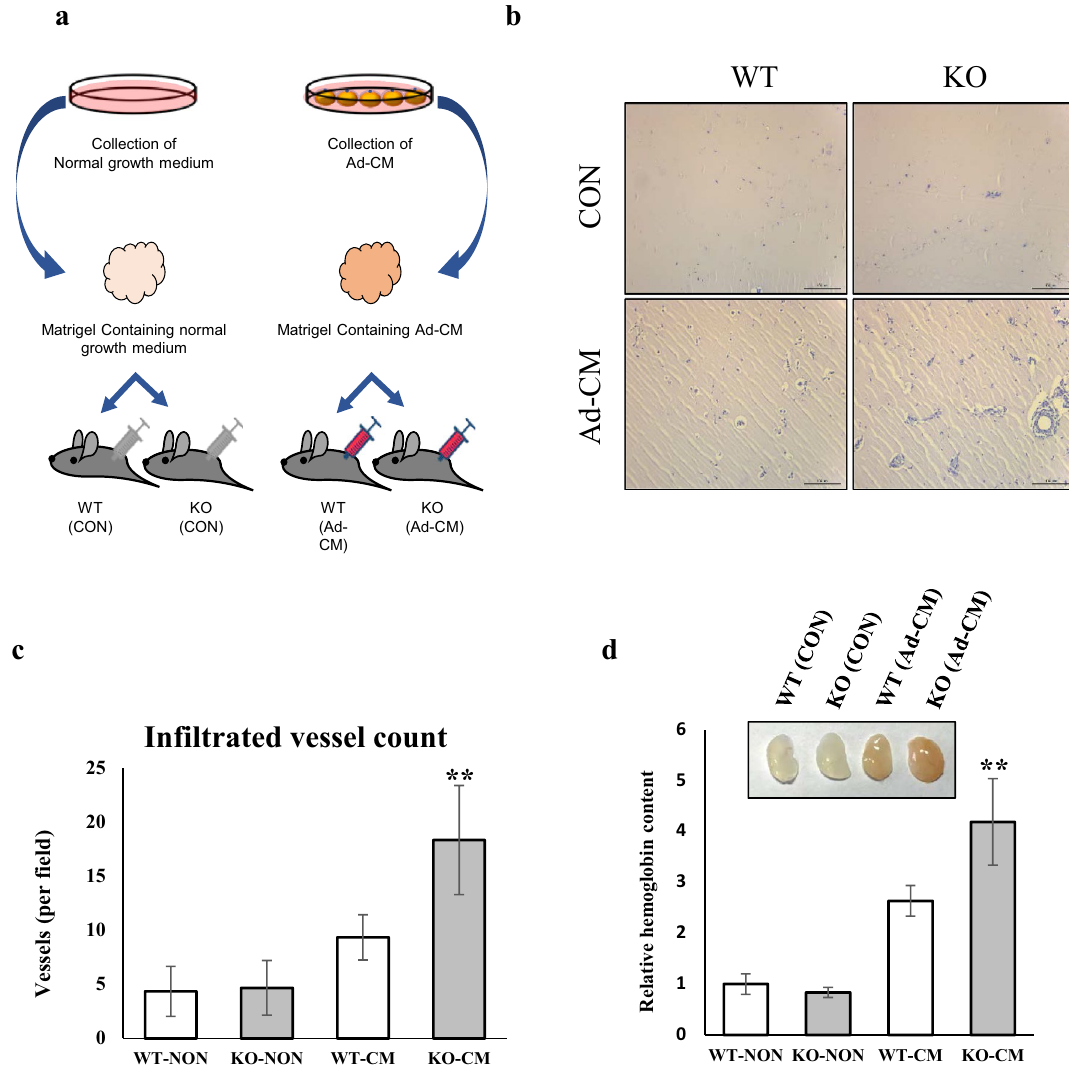
Figure 4. TGFBI modulates vessel infiltration into Matrigel containing Ad-CM. Matrigel impregnated with either normal medium or Ad-CM was injected in WT and KO mice. Normal medium: DMEM-high glucose, 10% FBS, and 1% antibiotics. (a) Schematic of the Matrigel plug assay in WT and TGFBI KO mice treated with Ad-CM. (b) Representative H&E staining section of Matrigel from WT and KO mice (n = 3/group). Scale bars represent 100 μm. (c) The infiltrated vessels were counted in three Matrigel H&E-stained sections and expressed as the mean number. Significant differences were evaluated between two groups of experiments in the same condition (WT-NON versus KO-NON or WT-CM versus KO-CM). (d) Relative hemoglobin content of Matrigel plugs. The insert image represents Matrigel for each group. Data are presented as the mean ± s.e.m. **p < 0.01 versus